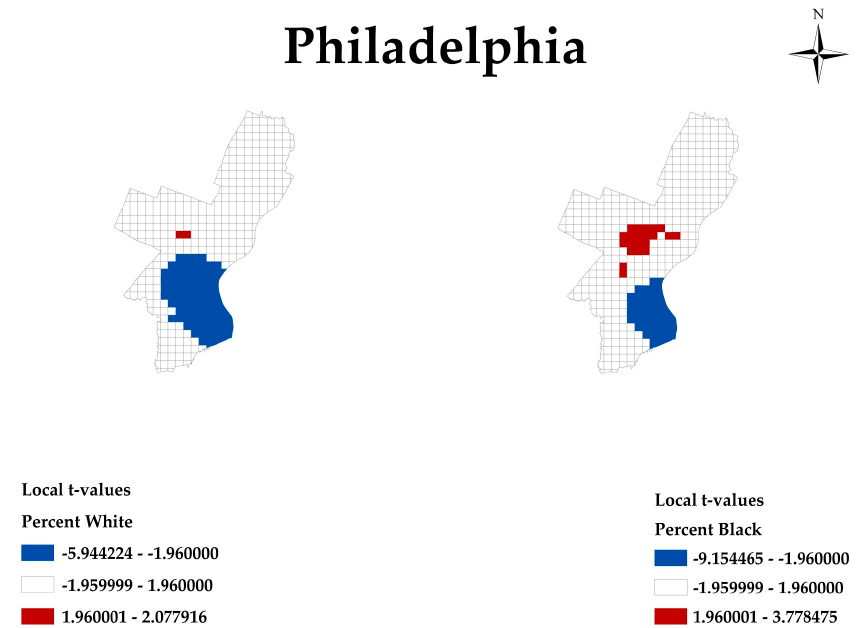
Figure 12. Philadelphia shrinking city Percent White and Percent Black: 95% two-tailed test ( − 1.96:1.96).